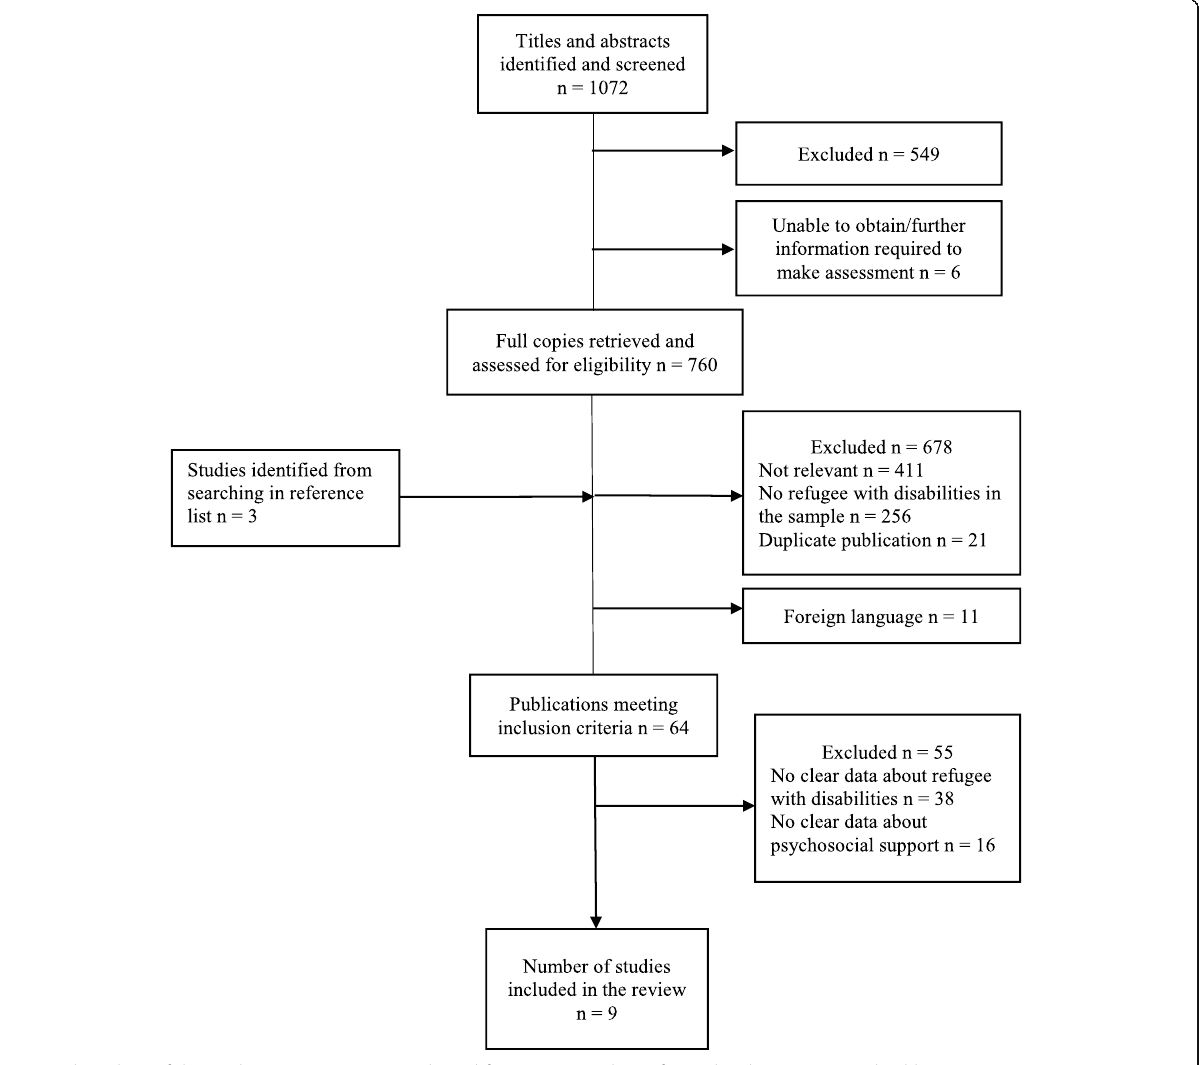
Fig. 1 Flow chart of the study screening process. Adapted from CRD ’ s guidance for undertaking reviews in healthcare